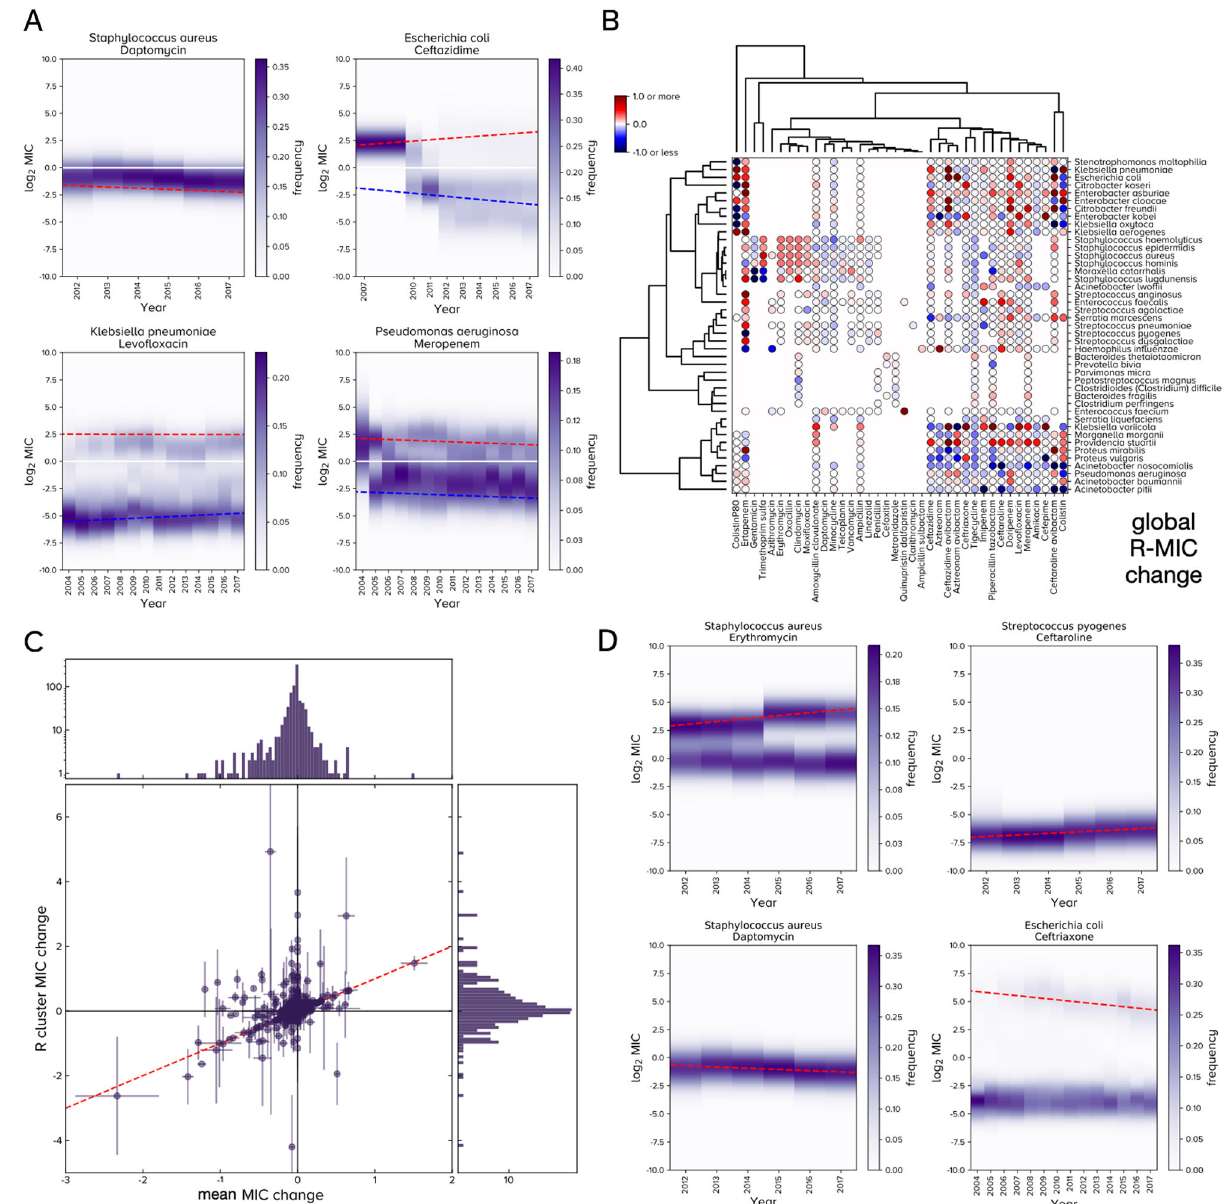
Fig. 6 The R-MIC and its global dynamics for pathogen-antibiotic (PA) pairs are different from mean MIC dynamics shown in Fig. 5. A Example dynamics of the S-MIC (blue dash) and R-MIC (red dash) are shown for 4 PA pairs: these have 1, 2 or 3 clusters in their MIC distributions and linear regressions predict the changes of the R-MIC (red) and S-MIC (blue). B Predicted global R-MIC changes per year for each PA pair (log 2 MIC change per year) are shown as a clustergram (the analogous plot with European data is similar, Supplementary Fig. 15B). C Changes in R-MIC (y-axis) and mean MIC (x-axis) are not well correlated (one dot per PA pair, ρ = 0.33, red dash shows `y = x' to highlight equal changes, crosshairs indicate s.d. from synthetic ATLAS replication, n = 50) because many PA pairs have R-MIC decreases and mean MIC increases and vice versa (c.f. Figs. 5B and 6B or Supplementary Figs. 15A and B). D These 4 PA pairs illustrate 4 MIC dynamics whereby R clusters have either sub- or super-breakpoint MICs which either increase or decrease (making 4 possible